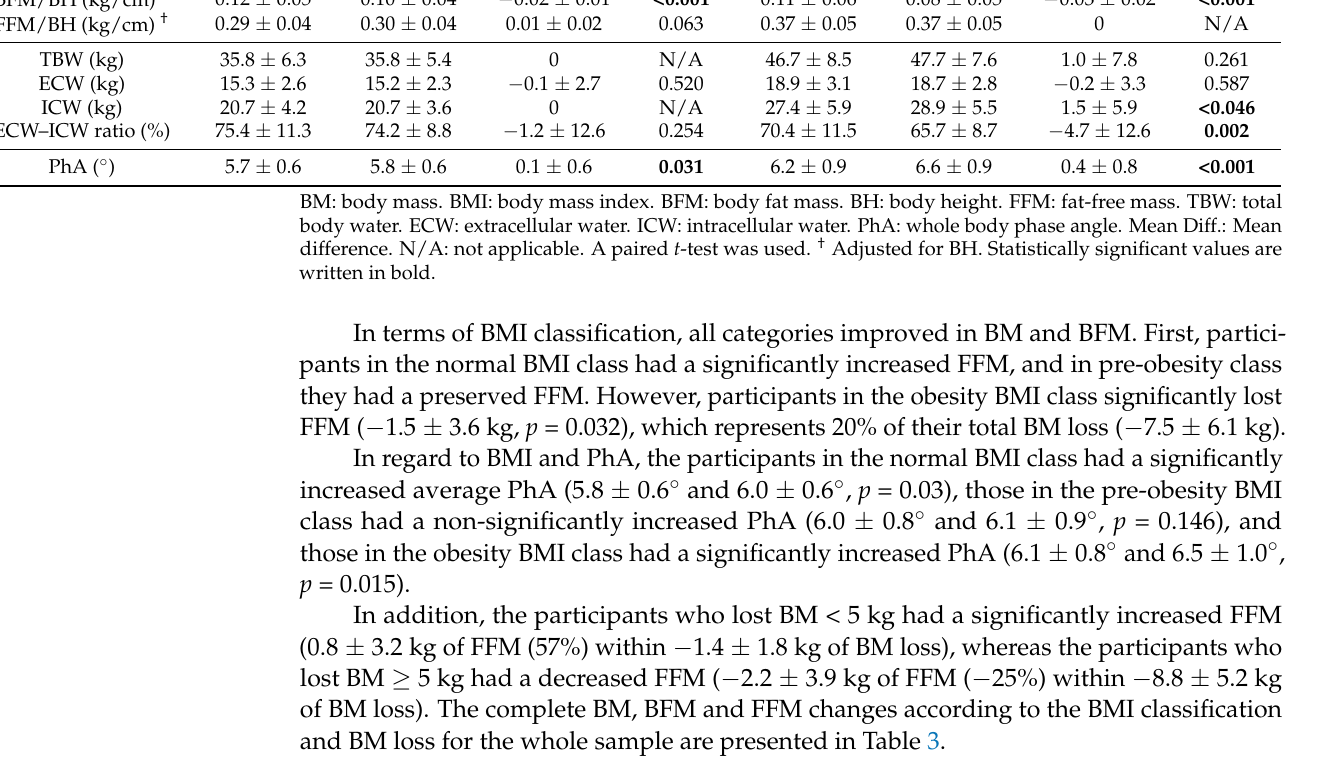
Table 3. Body mass, BFM and FFM change according to BMI classification and BM